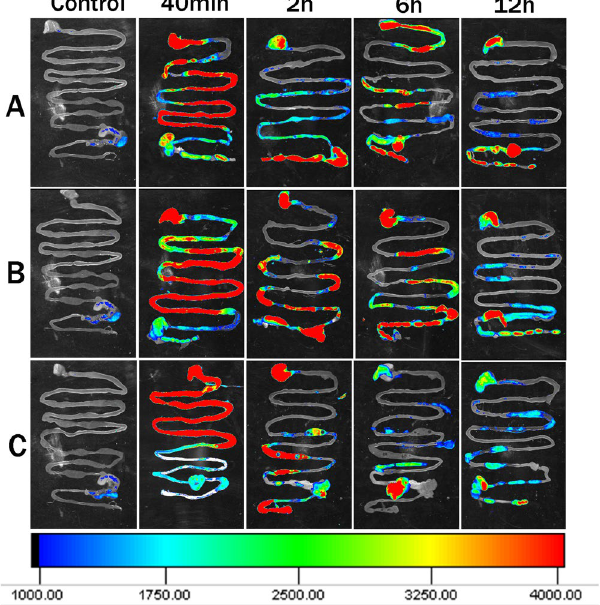
Figure 4. Gastrointestinal of Kunming mice sacrificed at different points after administration of three MSNs ( A -NLR; B -NSR; C -NS) were imaged using an ex vivo imaging system. The red, green, blue separately indicates the strongest, moderate and weakest